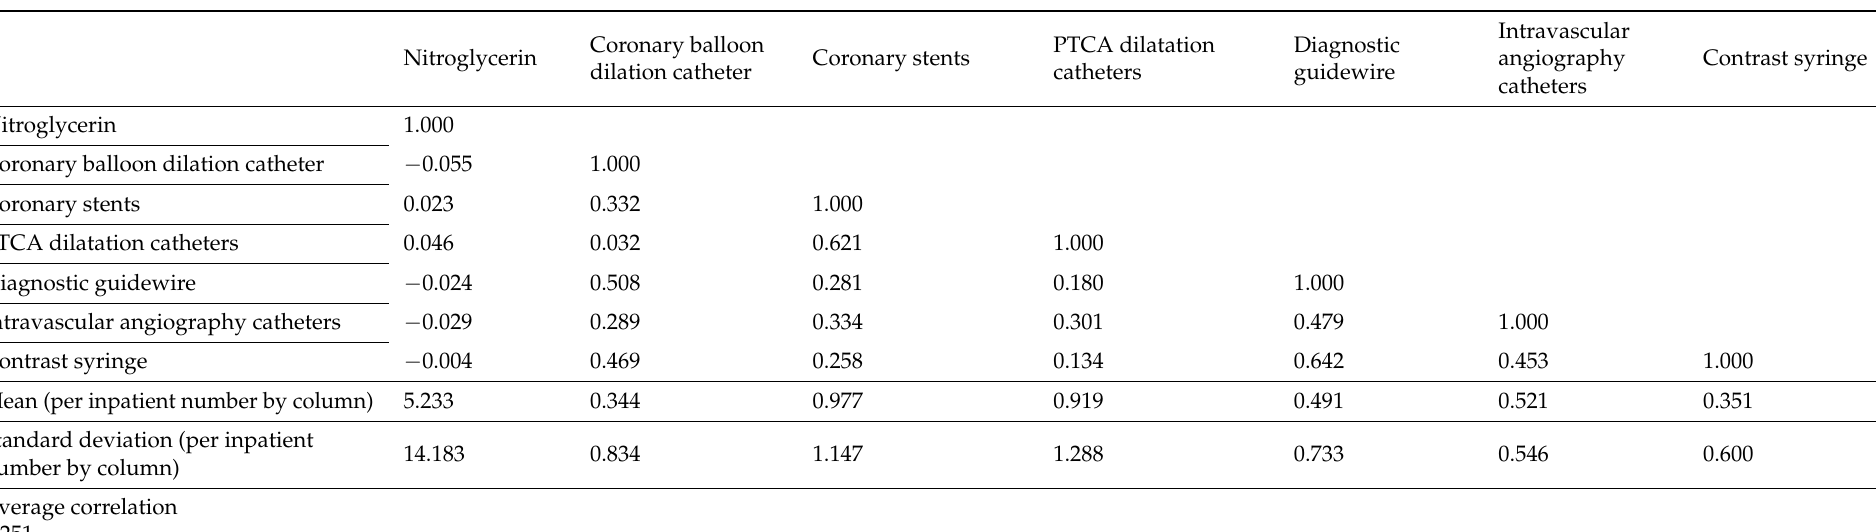
Table 9. The comparison of the correlation analysis results for resuscitation medicine and surgical related consumables used for Scenario Two’s study using quantity